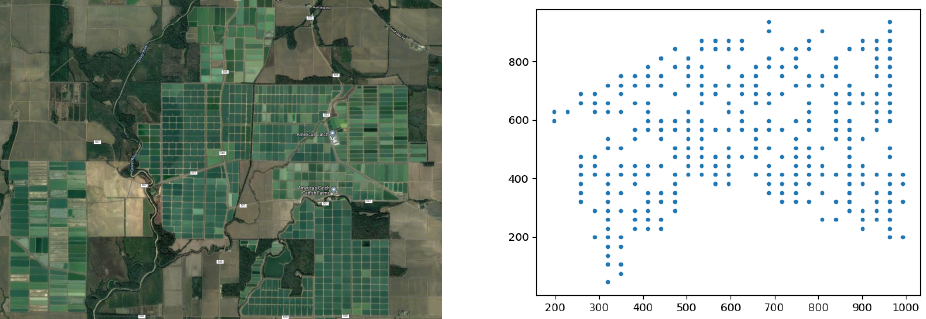
Figure 3. ( left ) America’s Catch Catfish Farm with approximately 700 ponds. ( right ) Example of 300 pond simulated aquaculture distribution. Adapted from [32].